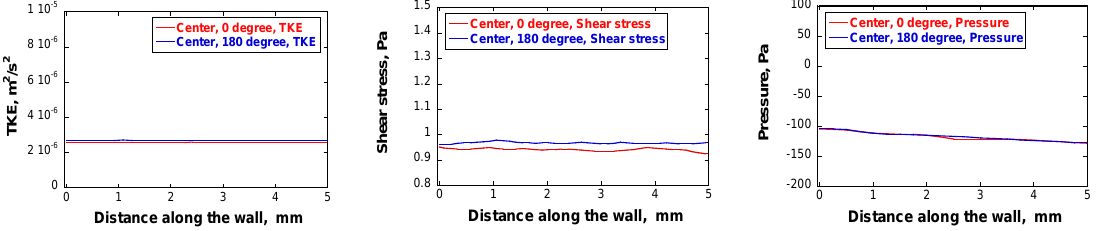
Figure 10. Effects of gravity on various hydrodynamic parameters.